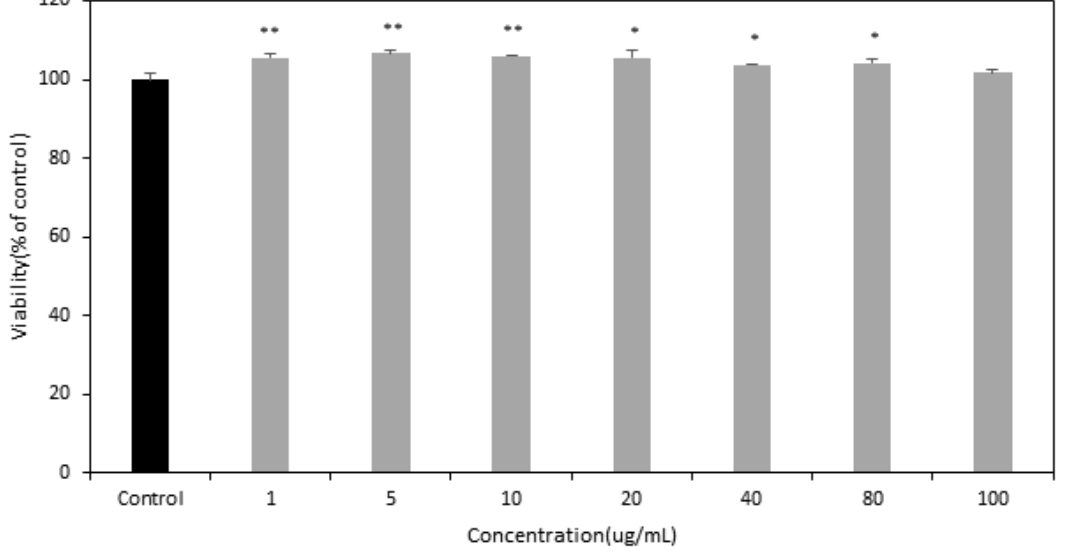
Figure 2. Effects of roasted Sacha inchi on HT22 cell viability. Cells were incubated with roasted Sacha inchi (1~100 µ g/mL) for 24 h on confluent cells, and the viability was quantified by an MTT assay. Results of cell viability are expressed as percentage of untreated control cells. Results of three independent experiments were averaged and are presented as mean ± standard deviation. Data were subjected to one-way ANOVA followed by Tukey’s multiple comparisons using IBM SPSS statistics 23 (level of significance, * p < 0.05, ** p < 0.01).